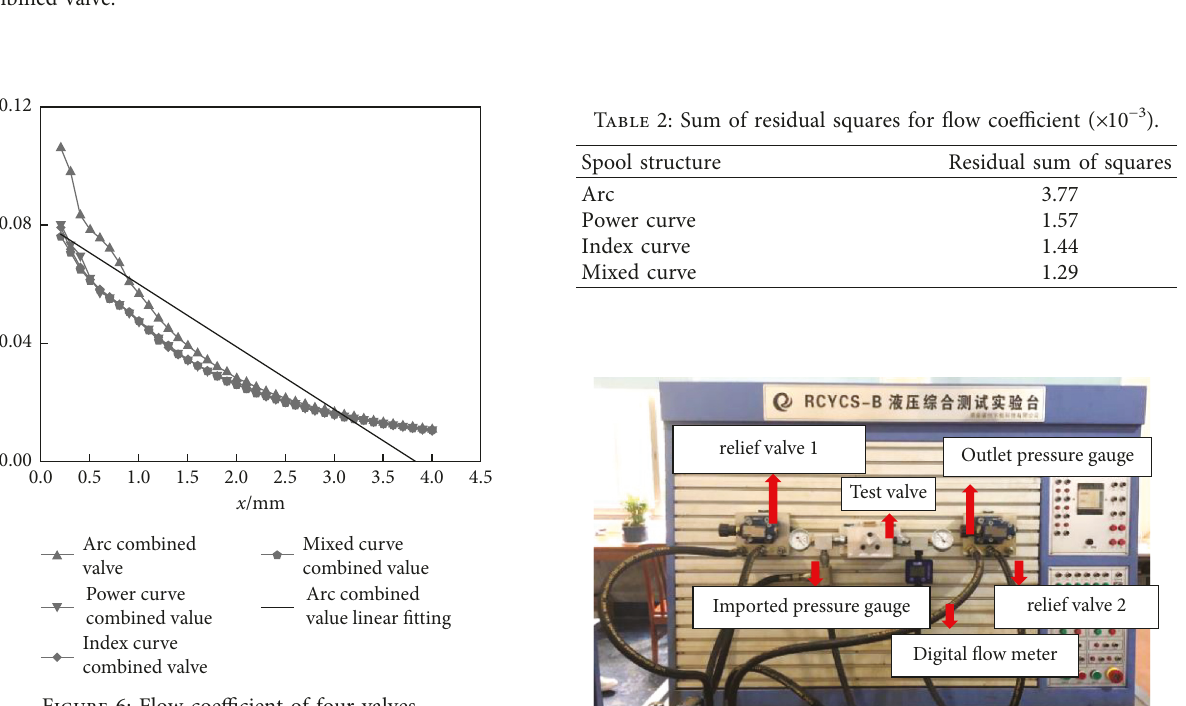
Figure 5: Combined valve port flow area. (a) Streamline diagram of combined valve port speed. (b) Schematic diagram of the flow area of the combined valve.